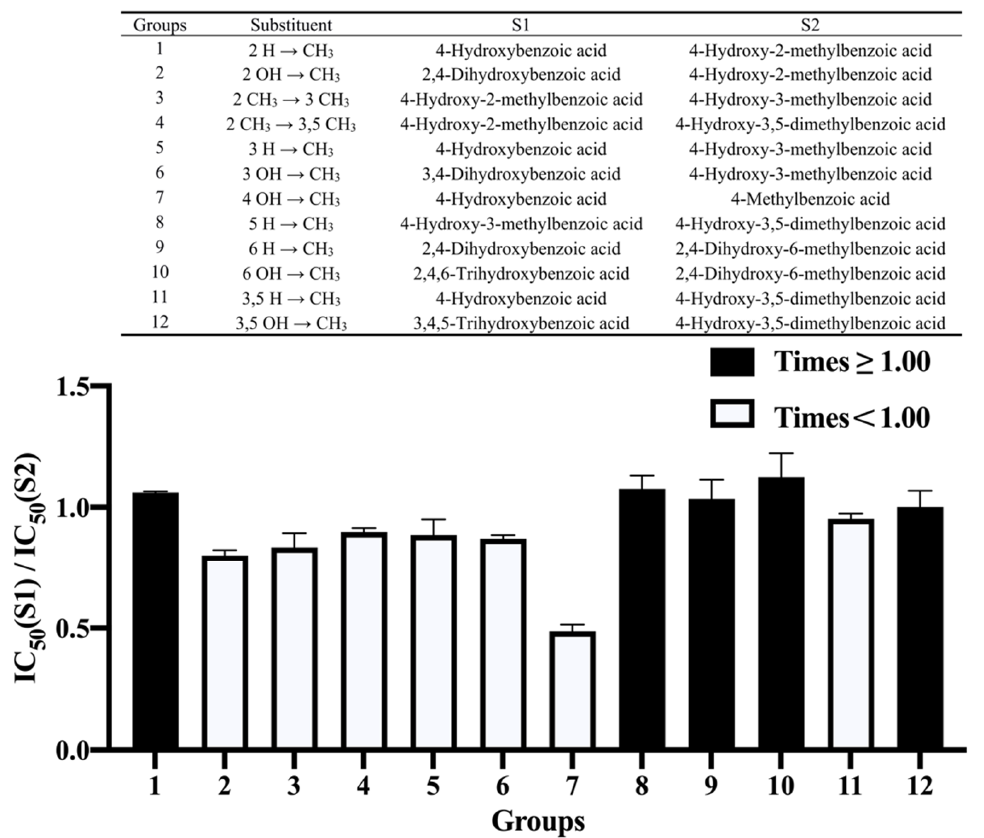
Figure 3. The effect of methylation on the benzene ring on the inhibition of α -amylase by benzoic acid and its derivatives. S1—Structure 1; S2—Structure 2.